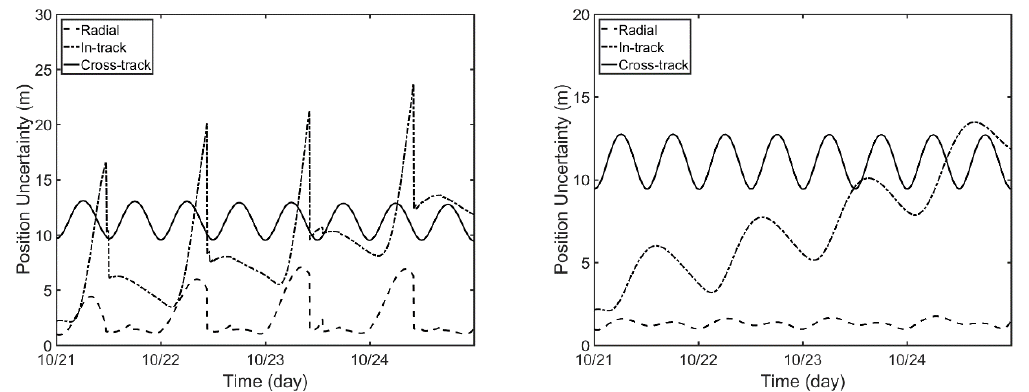
Figure 11. Position uncertainty of filter ( left ) and smoother ( right ) from Compass-G1 orbit determination (OD).